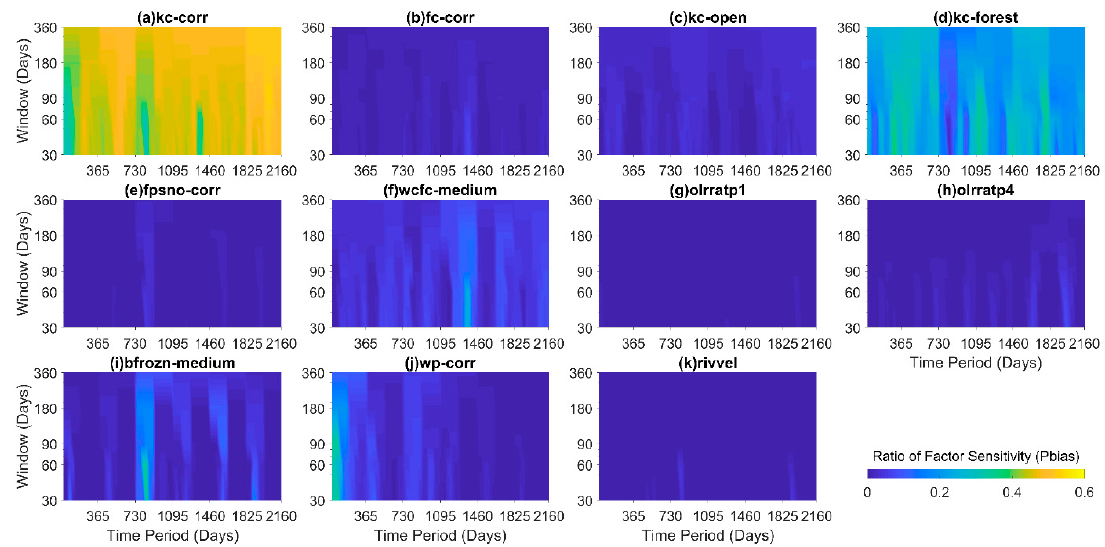
Figure 9. Ratio of factor sensitivity for moving windows of 30 days, 60 days, 90 days, 180 days and 360 days using PBIAS as the evaluation criteria from 01/01/2000 to 29/11/2005.